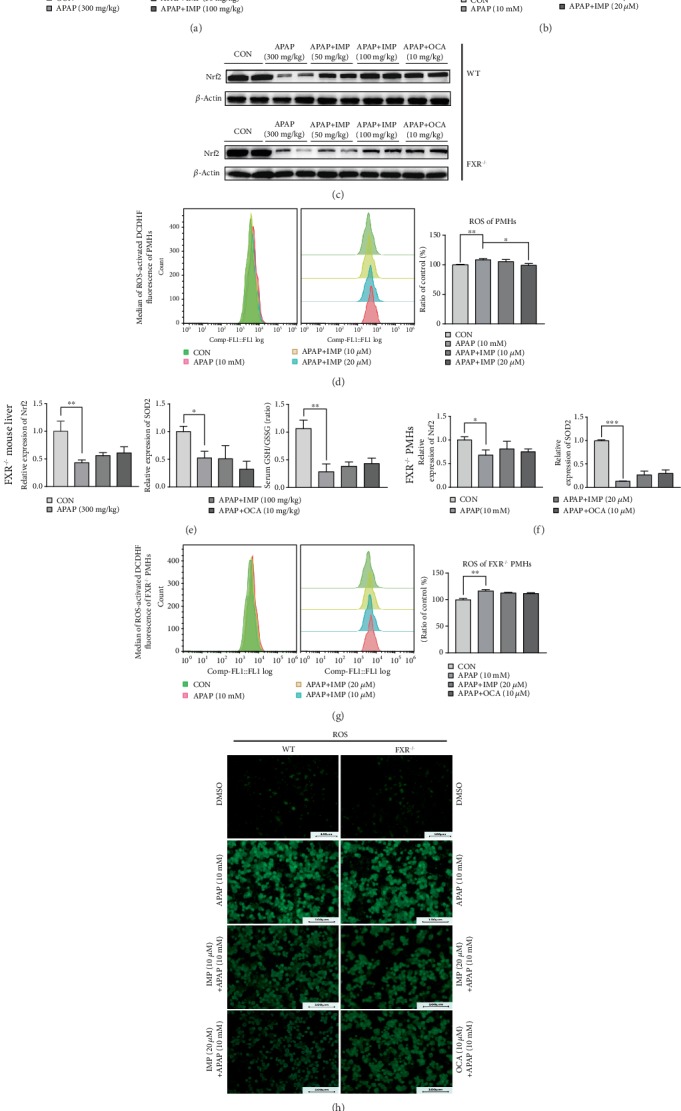
Effects of IMP pretreatment protect mice against APAP overdose-induced oxidative stress damage. (a) The relative expression of Nrf2 and SOD2 in WT mouse liver tissue and the serum level of GSH/GSSG. (b) The relative expression of Nrf2 and SOD2 in WT PMHs. The mRNA levels of Nrf2 and SOD2 from tissue and cells were determined by qRT-PCR. (c) The protein expression of Nrf2 in FXR−/− mice. (d) The expression of ROS in WT PMHs. The expression of ROS was measured by flow cytometry. (e) The relative expression of Nrf2 and SOD2 in FXR−/− mouse liver tissue and the serum level of GSH/GSSG. (f) The relative expression of Nrf2 and SOD2 in FXR−/− PMHs. The mRNA levels of Nrf2 and SOD2 from tissue and cells were determined by qRT-PCR. (g) The expression of ROS in FXR−/− PMHs. The expression of ROS was measured by flow cytometry. The ratio of each group to the control group was obtained. (h) ROS fluorescent in FXR+/+ and FXR−/− PMHs. Results are expressed as fold changes compared to the vehicle-treated control group. ∗p < 0.05; ∗∗p < 0.01; ∗∗∗p < 0.001. GSH: reduced glutathione; GSSG: oxidized glutathione; Nrf2: nuclear factor erythroid 2-related factor 2; SOD2: superoxide dismutase-2; qRT-PCR: quantitative real-time PCR; ROS: reactive oxygen species.